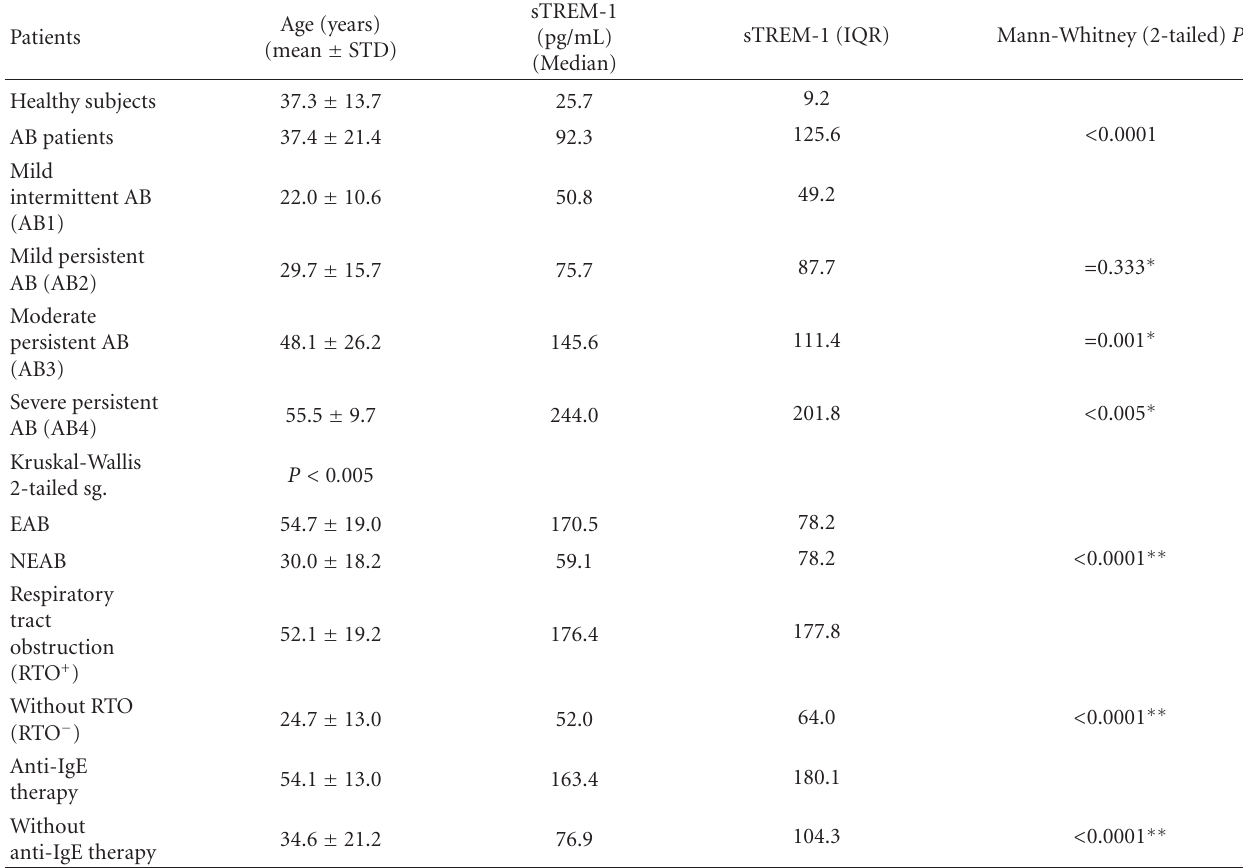
Table 2: Plasma levels of sTREM-1 in healthy subjects and asthma bronchiale